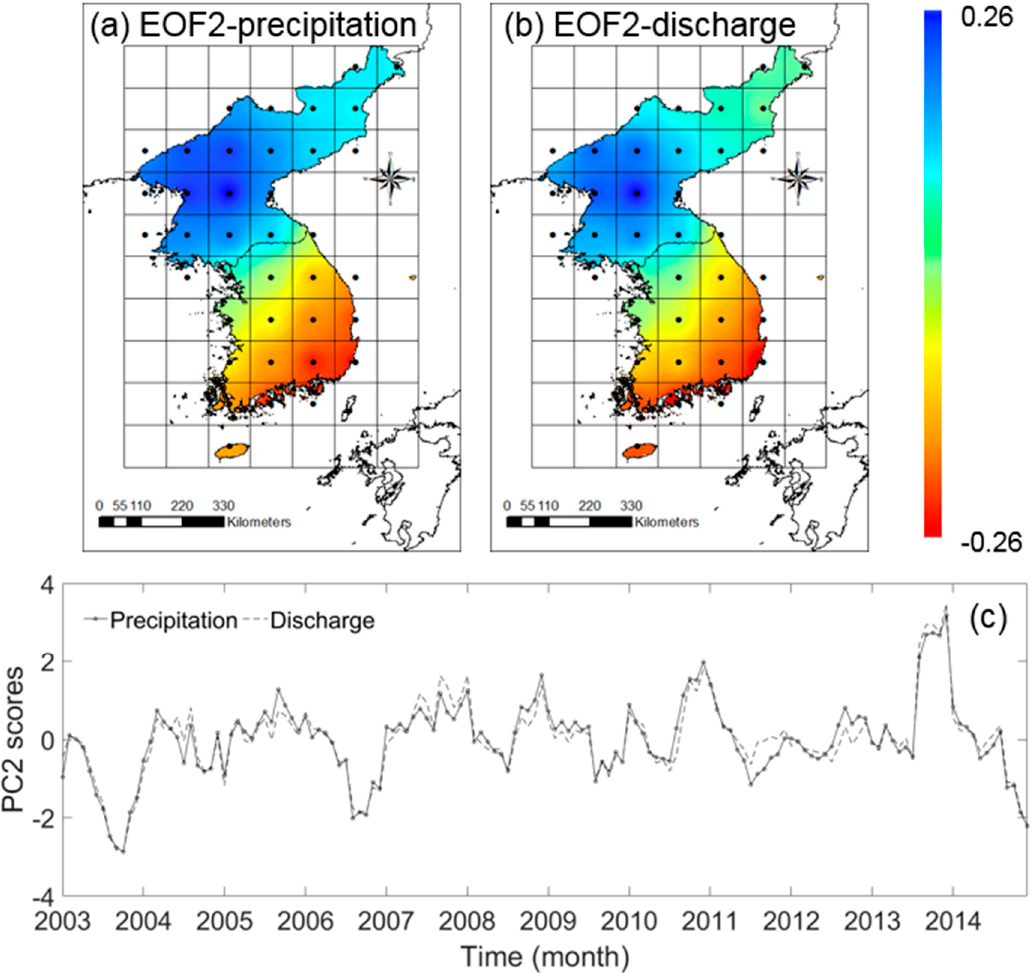
Figure 8. ( a ) Precipitation EOF-2 (variance = 6.4%); ( b ) Discharge EOF-2 (variance = 10.6%); ( c ) Score time series for PC2 of monthly precipitation and discharge,